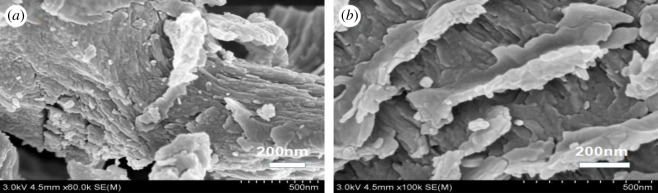
SEM images of UVS.